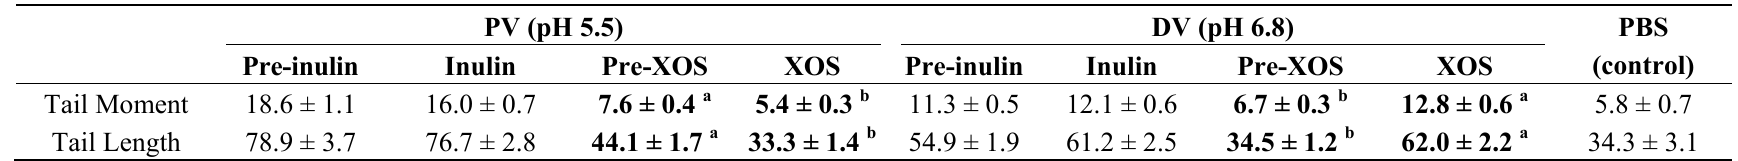
Table 2. Faecal water genotoxicity of low amylose cornstarch, inulin and XOS in a human colonic simulator. Genotoxicity (mean ± SEM) was measured as numbers of DNA single strand breaks in cultured colonic cells using the comet assay following incubation of the cells with faecal water. Data are presented as tail moment and tail length. PV: proximal vessel; DV: distal vessel.